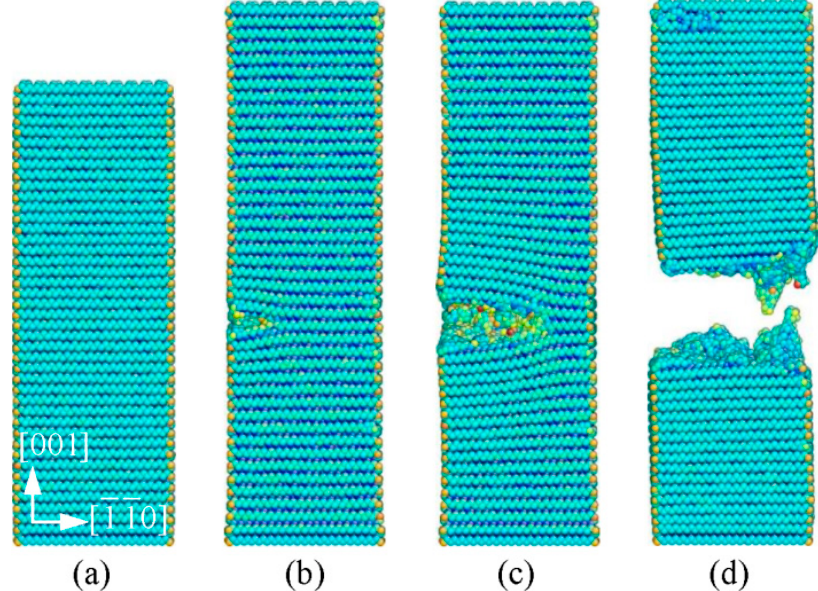
Figure 3. Atomistic configurations of the <100>/{110} silicon nanowire with width of 7.7 nm at different tensile strain levels. Atoms are colored according to their potential energy, with blue indicating low value and red representing high value. ( a ) ε = 0, ( b ) ε = 0.189, ( c ) ε = 0.191 and ( d ) ε = 0.196.